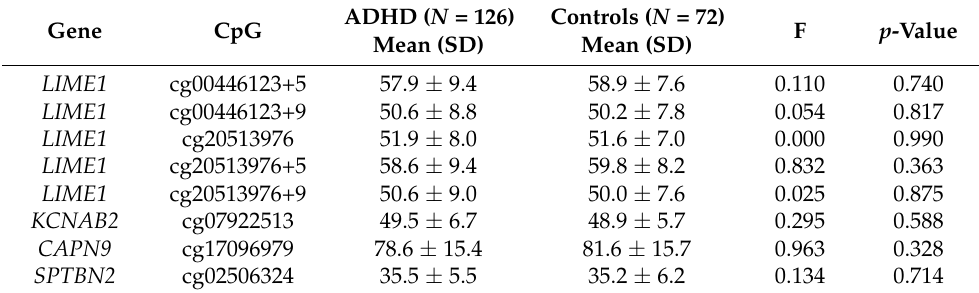
Table 2. DNA Methylation Levels of Patients with ADHD and Healthy